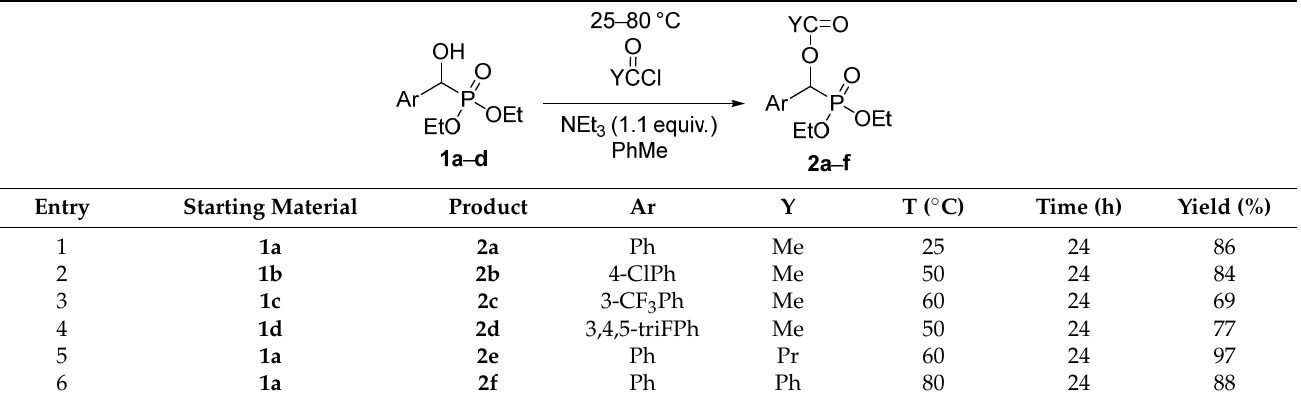
Table 2. The acylation of diethyl α -hydroxy-arylmethylphosphonates 1a – d .